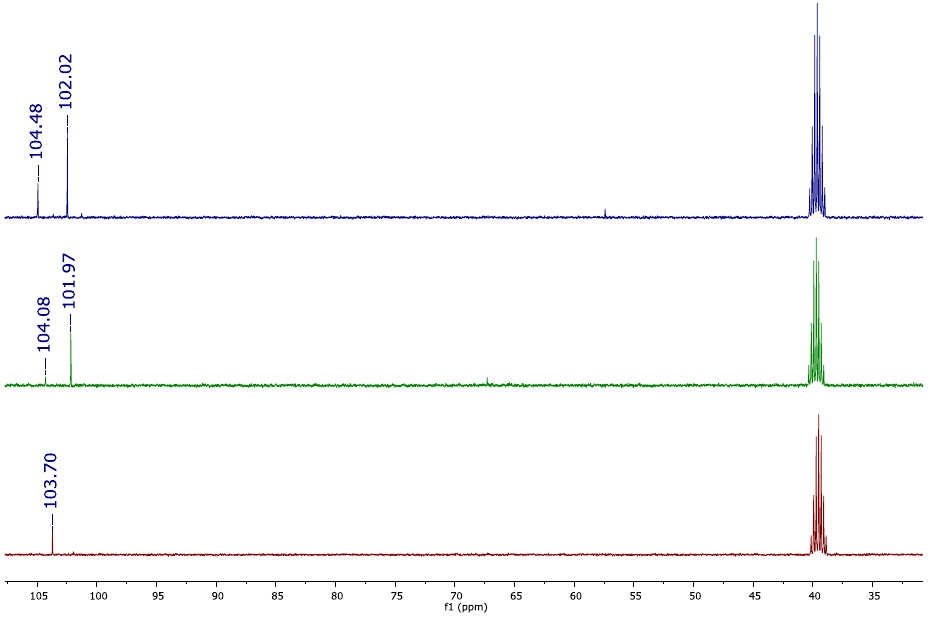
Figure 2. 13 C{ 1 H} NMR spectra of Se(CN) 2 (red), Se 2 (CN) 2 (green) and Se 3 (CN) 2 (blue) in DMSO-d 6 .